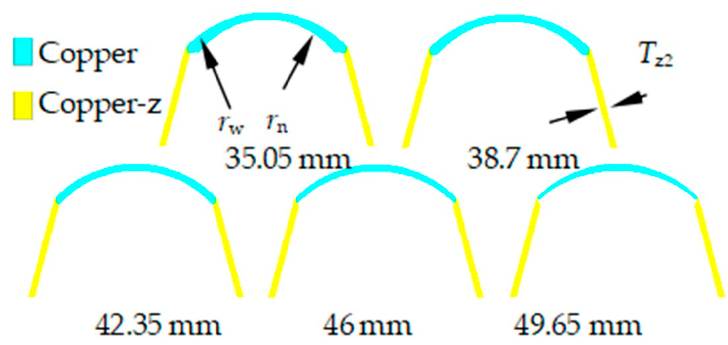
Figure 12. SCS liner with different inner surface bus radius.